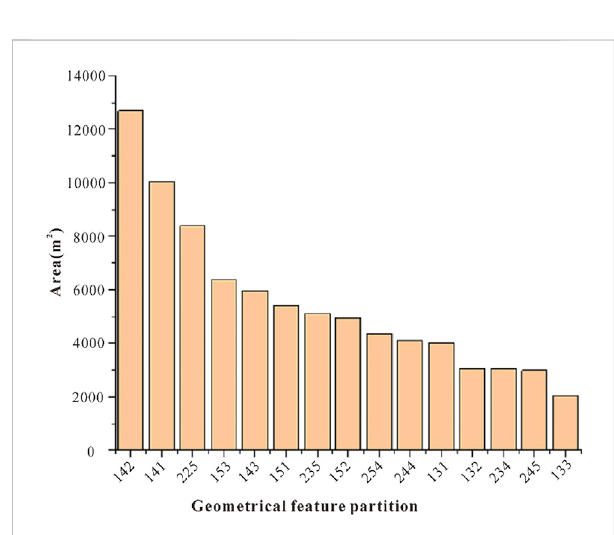
FIGURE 6 Bank slope geological geometric partitioning unit area of statistical